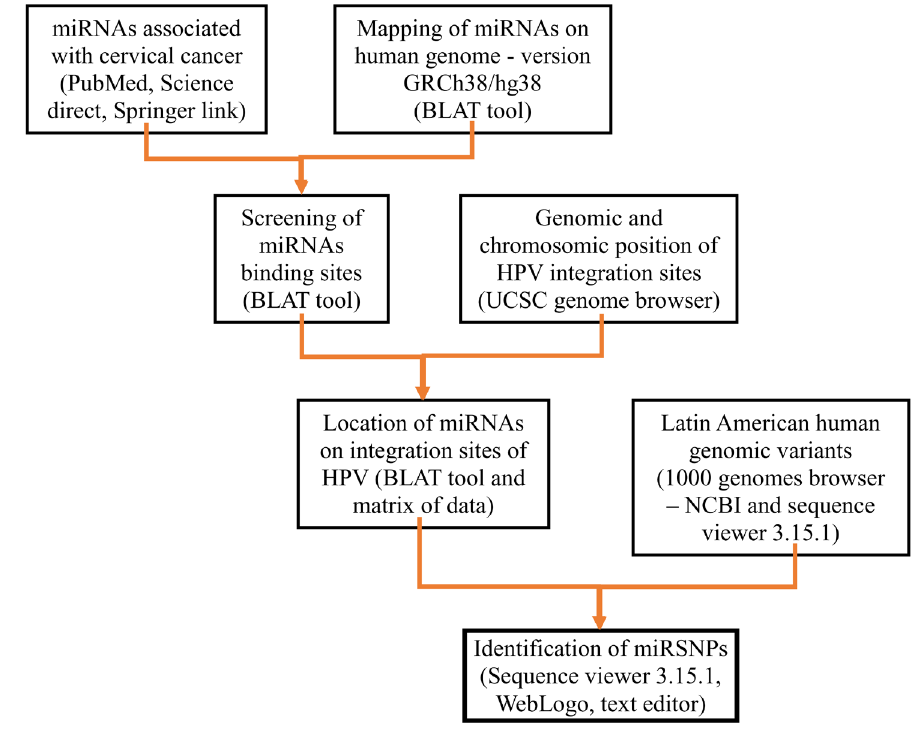
Figure 1. Bioinformatic workflow for mapping of miRNAs related to CC on Latin American human genomic variants.